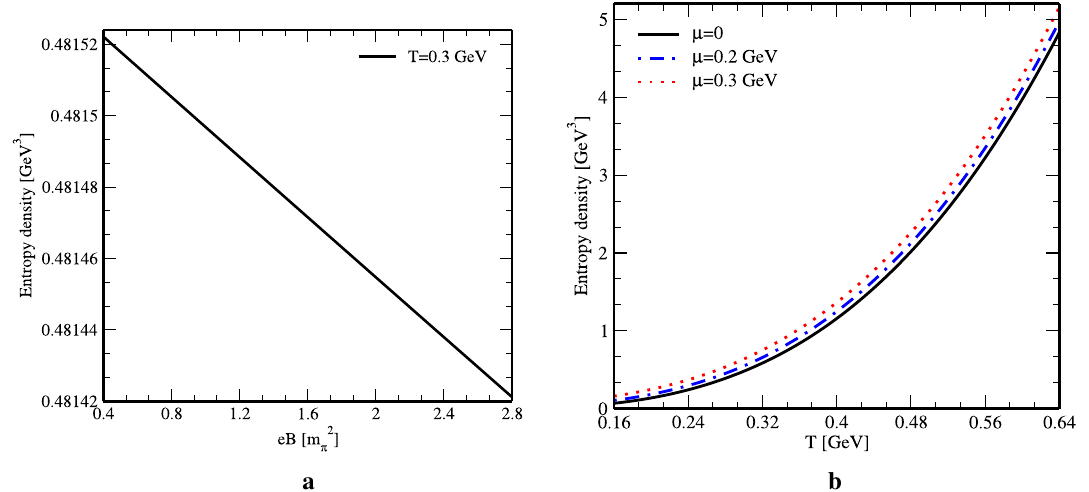
Fig. 7 The variation of the entropy density ( a ) with magnetic field at a fixed temperature and ( b ) with temperature at different values of chemical potential